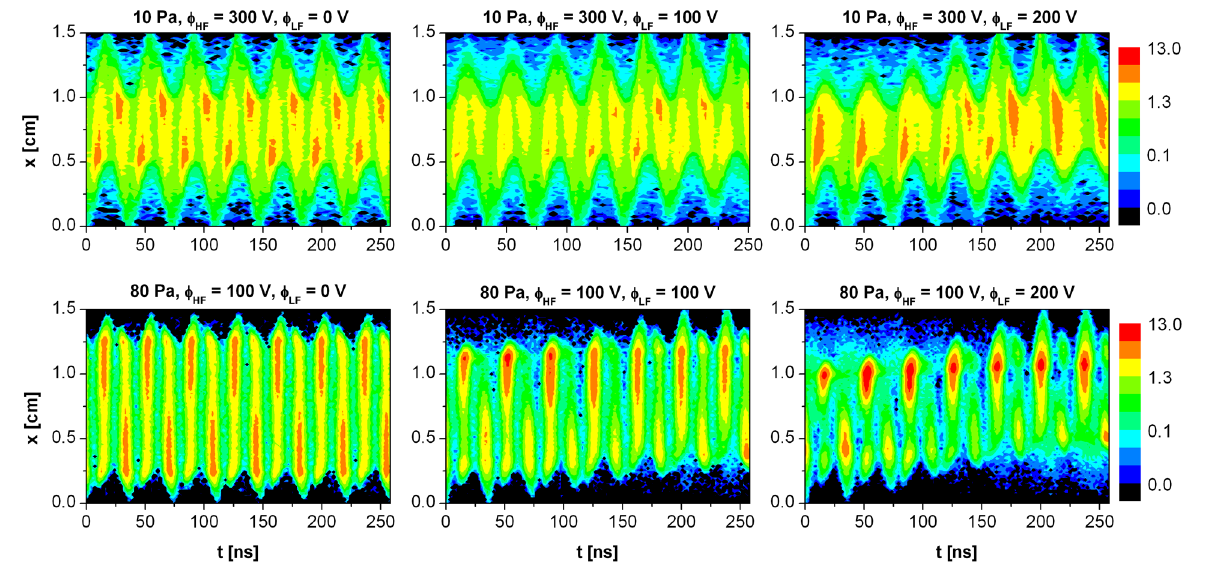
Figure 2 : Spatio-temporal distribution of the ionization rate in classical dual-frequency discharges operated at 1.937 MHz + 27.12 MHz for different values of the low-frequency voltage amplitude, Φ , at 10 Pa (first row) and at 80 Pa (second row). First column: Φ LF column: Φ =100 V. Third column: Φ =200 V. Φ =300 V at 10 Pa. Φ =100 V at 80 Pa. The color scales, given in 10 21 m -3 s -1 , are logarithmic, LF LF HF HF and apply to all plots in the same row. The horizontal axis corresponds to half of the LF period. The vertical axis shows the distance from the powered